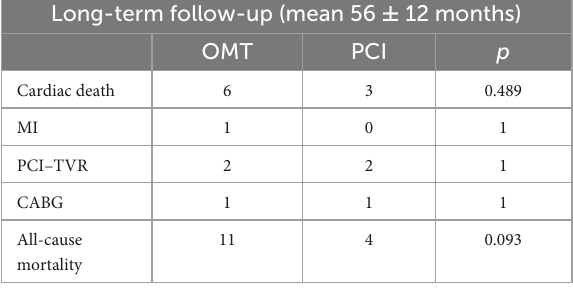
TABLE 2 Clinical outcomes: long-term follow-up. Long-term follow-up (mean 56 ± 12 months)